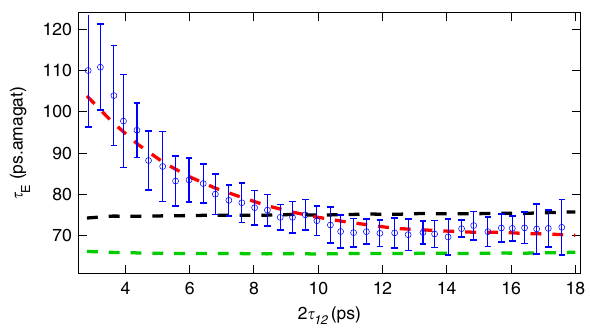
Fig. 3 Time constants of collisional dissipation of N 2 O. The blue circles with error bars (representing two standard deviations of the mean) are the density-normalized decay time constants τ E of the echoes deduced from the measurements of the alignment signal recorded at various N 2 O(4%) + He(96%) gas densities and fi xed delays τ 12 between the two pulses. The dashed lines denote the results of simulations conducted by solving the density matrix equations for molecules impulsively aligned by two short laser pulses and interacting with each other through collisions. The green and black dashed lines have been obtained using the standard Bloch equations (i.e., using the secular approximation) with initial N 2 O rotational populations corresponding to temperatures of T = 100 K and 295 K, respectively. The red dashed line represents the results obtained, for populations associated with T = 100 K (see text), using the nonsecular Red fi eld equations, i.e. including all relaxation terms in Eq. (3).